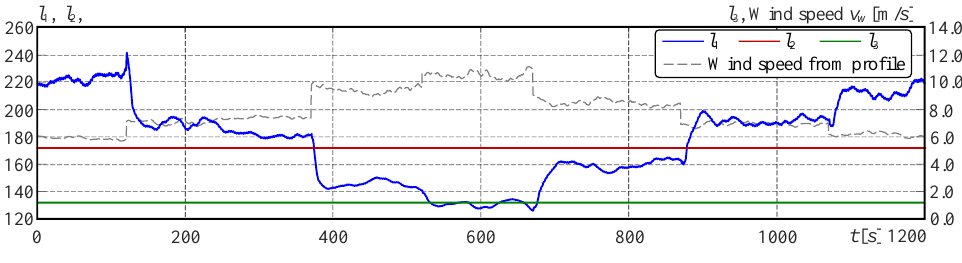
Figure 7. Observer gains.